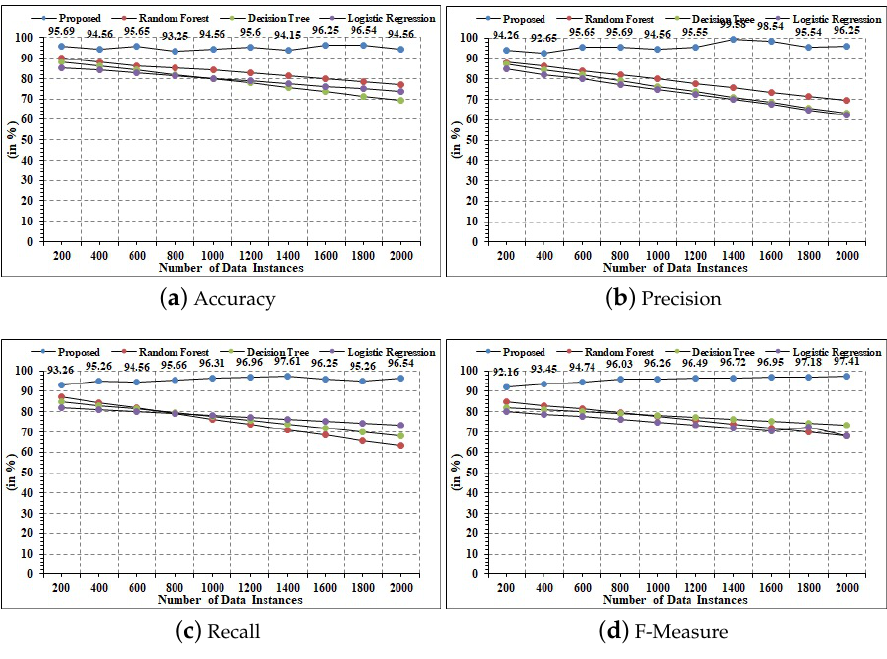
Figure 14. Statistical